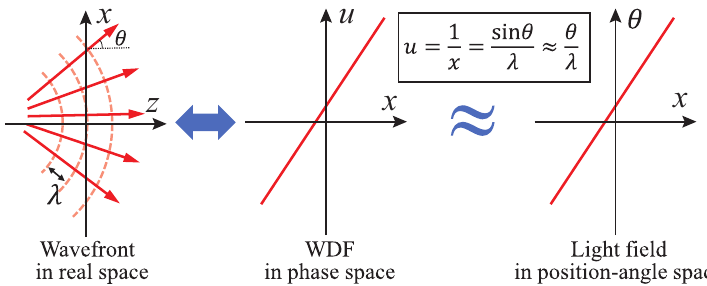
Figure 21. The WDF and light field of a smooth coherent wavefront. Phase is represented as the localized spatial frequency (instantaneous frequency) in the WDF representation. Rays travel perpendicularly to the wavefront (phase normal), (Reprinted from Optics and Lasers in Engineering, 71, Chao Zuo, Qian Chen, Lei Tian, Laura Waller, Anand Asundi, Transport of intensity phase retrieval and computational imaging for partially coherent fields: The phase space perspective, 13, Copyright (2015), with permission from Elsevier [173].)